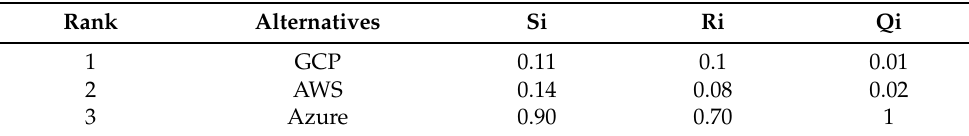
Table 5. Scenario 4: Dormant